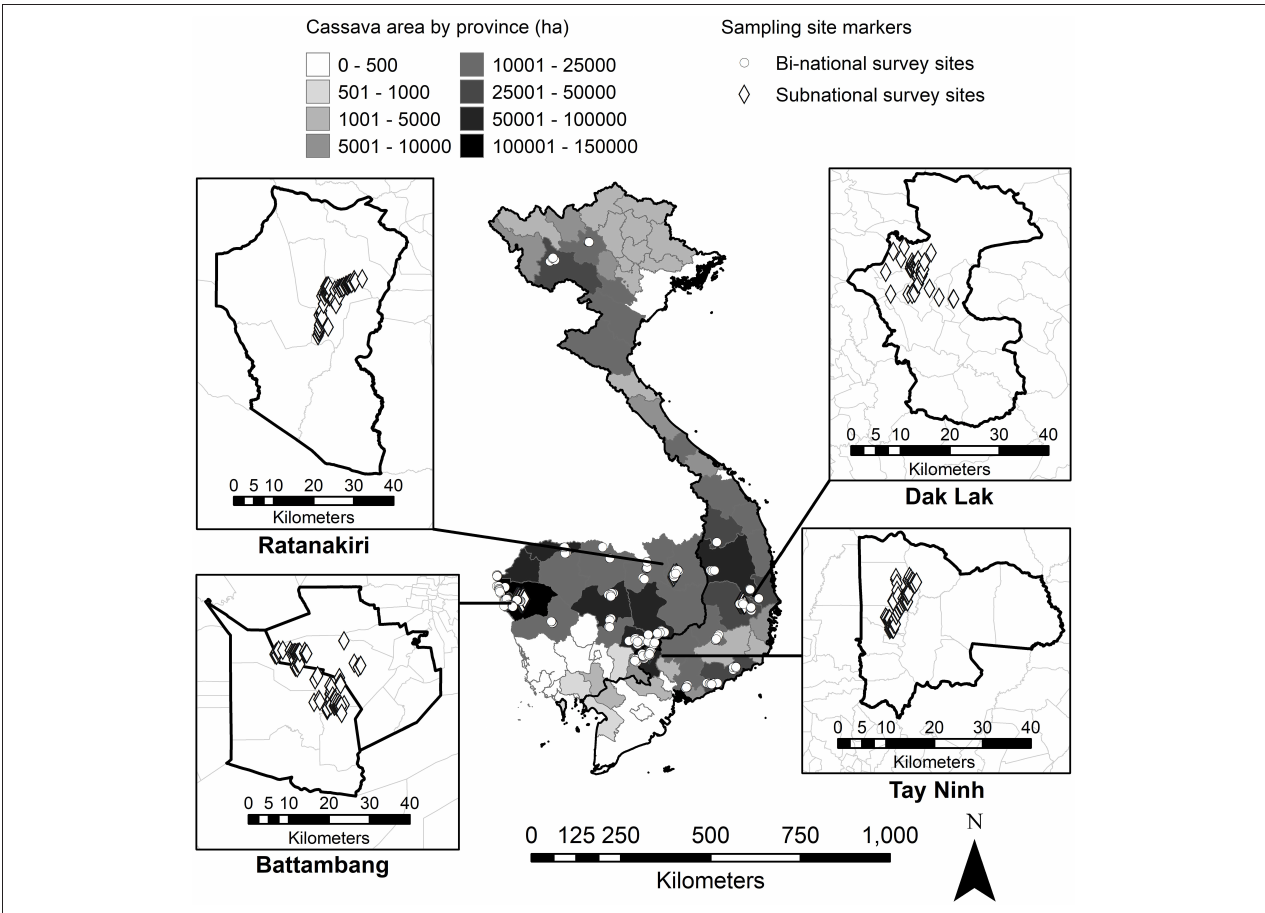
FIGURE 1 | Project map indicating the location of farmer surveys in Vietnam and Cambodia in 2016–2017. GPS locations of bi-national and subnational survey sites are indicated by circle and diamond symbols, respectively. Thick borders in the inset maps indicate district boundaries. Gray scale shading indicates cassava area, calculated by province for 2016 (sources: General Statistics Office, Ministry of Planning and Investment, Vietnam; General Directorate of Agriculture, Ministry of Agriculture Forestry and Fisheries, Cambodia).